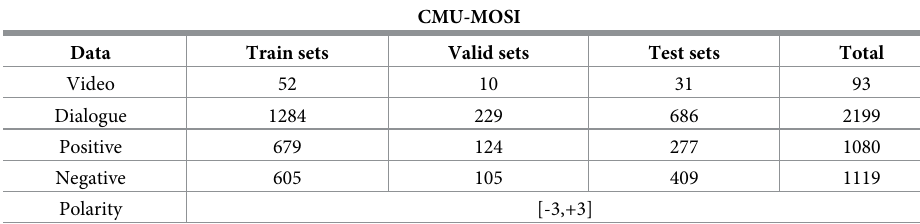
Table 1. CMU-MOSI dataset